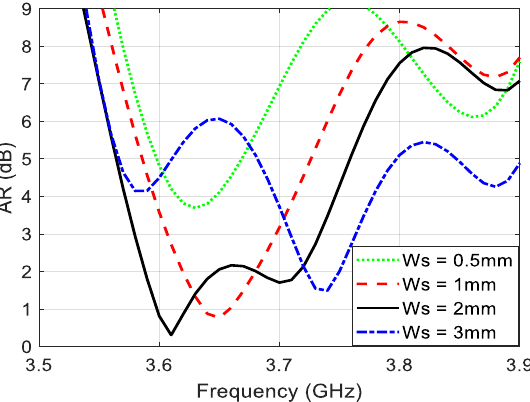
Figure 4. Broadside AR of the proposed microstrip antenna of slits at 𝑑 = 1.5 𝑚𝑚 and different values of 𝑊𝑠 .